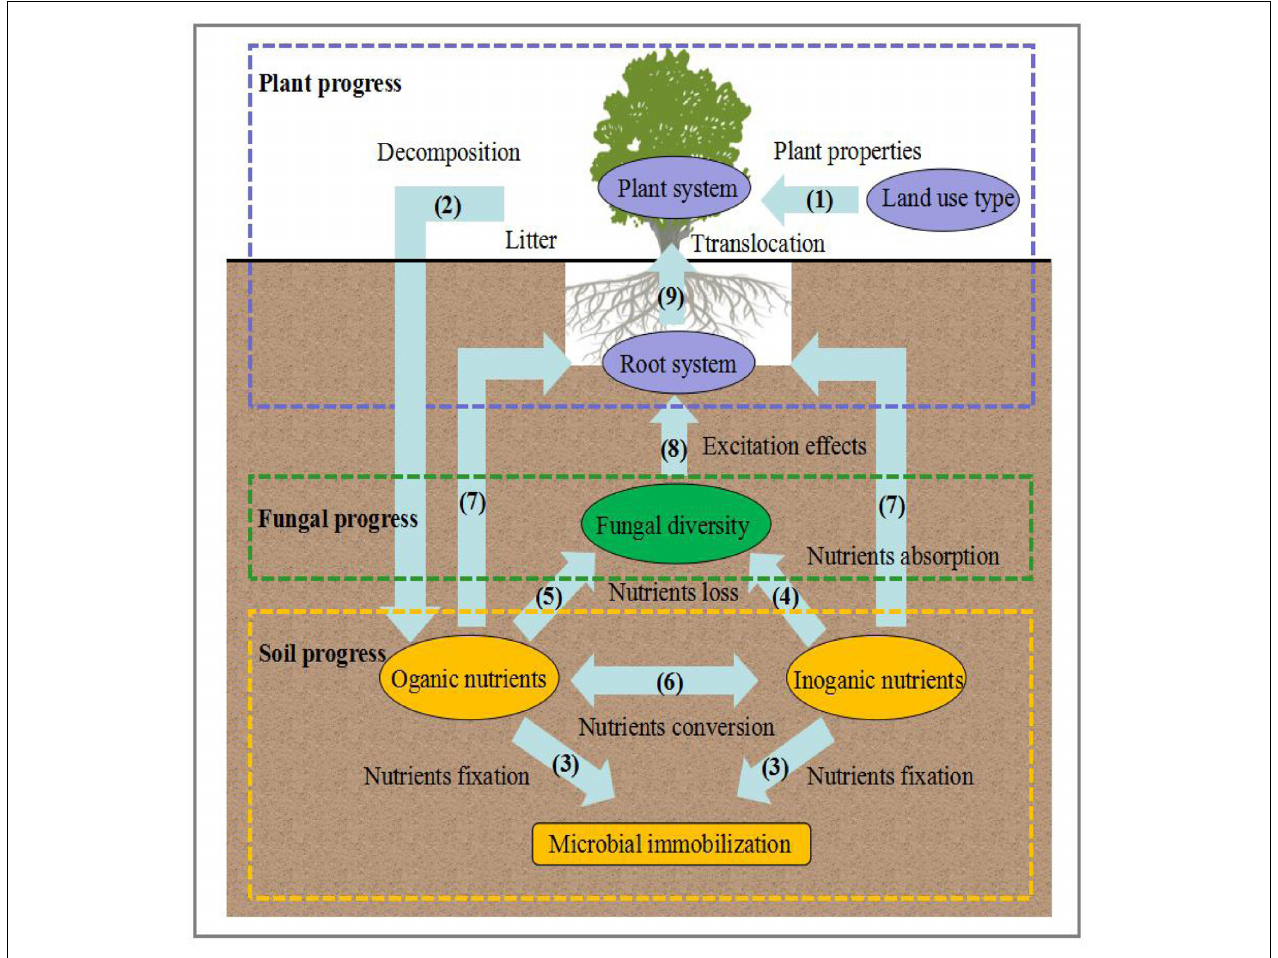
FIGURE 6 | Conceptual model of the expected causal relationships among fungal diversity composition and soil and plant